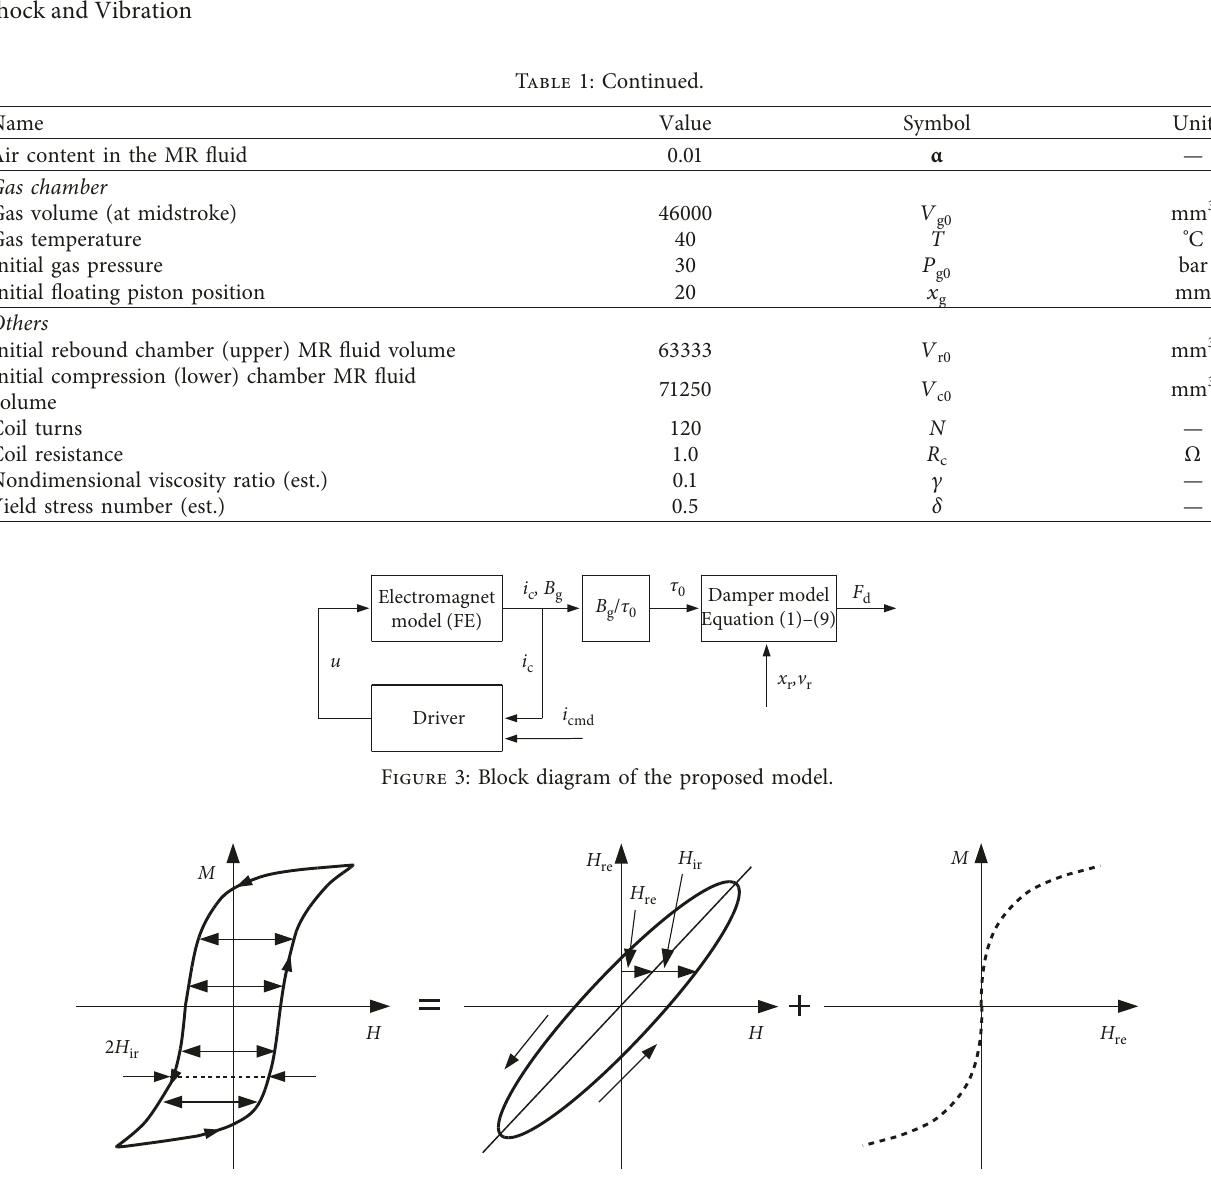
Figure 4: Magnetic field decomposed into reversible/irreversible components [35].